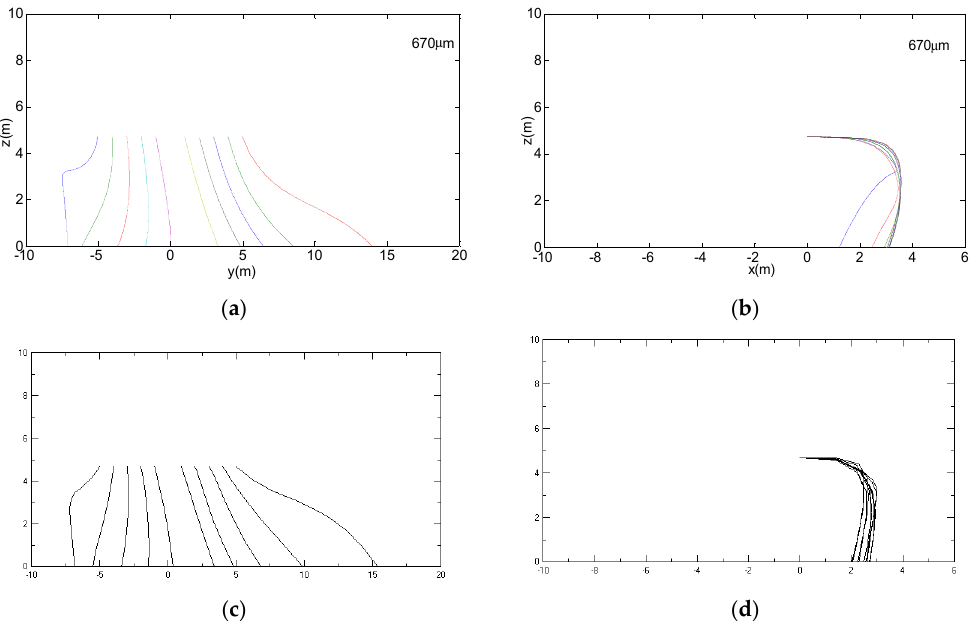
Figure 19. Comparisons of trajectories of 670 µ m droplets in the IGE model and AGDISP from two views, two respective figures in the up (IGE model) and down (AGDISP) have the same scale and unit of measure: ( a ) yz plane (rear view of an aircraft) based on IGE model; ( b ) xz plane (right view of an aircraft) based on IGE model; ( c ) yz plane (rear view of an aircraft) based on AGDISP; ( d ) xz plane (right view of an aircraft) based on